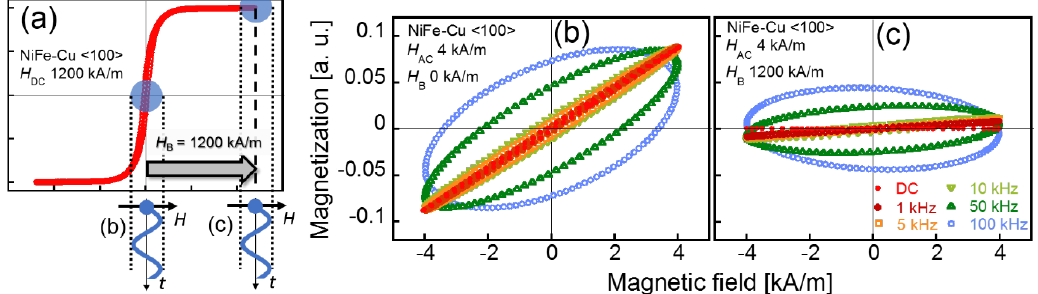
Figure 6. DC magnetization curve along the < 100 > crystallographic axis of the NiFe-Cu nanocubes, and a schematic of the applied AC field and DC bias field for AC magnetization measurement ( a ), AC magnetization curves of the sample obtained without the DC bias field ( H B = 0) ( b ), and with a DC bias field ( H B = 1200 kA/m) ( c ).